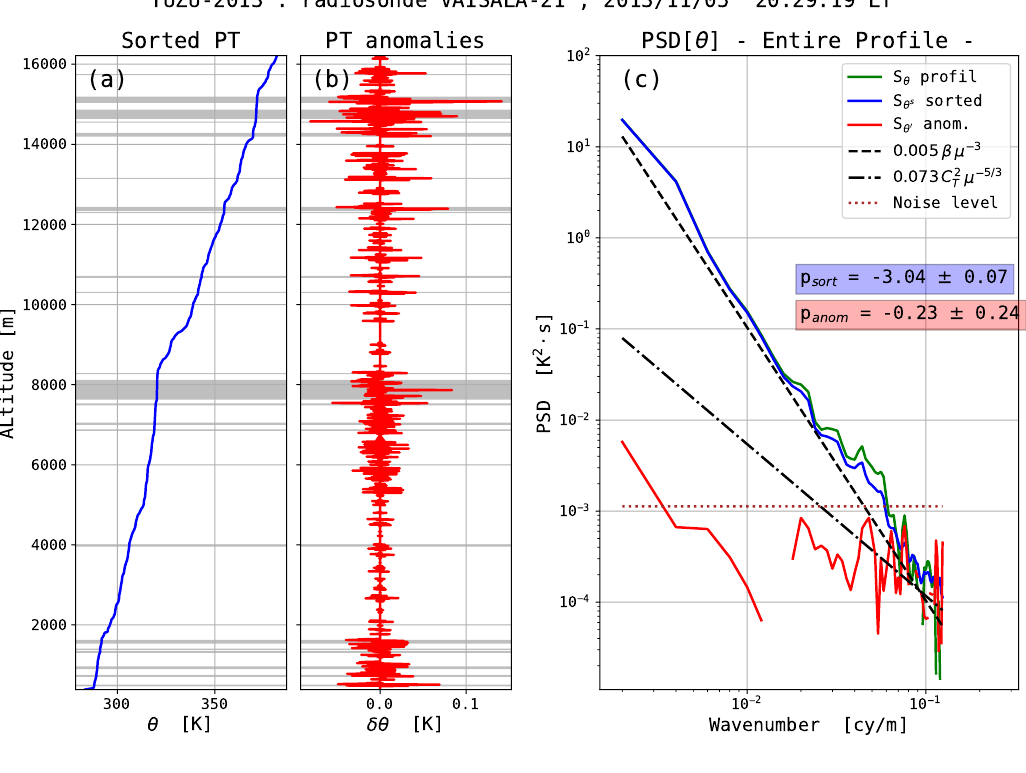
Figure 13. Same as Figure 12 but for flight